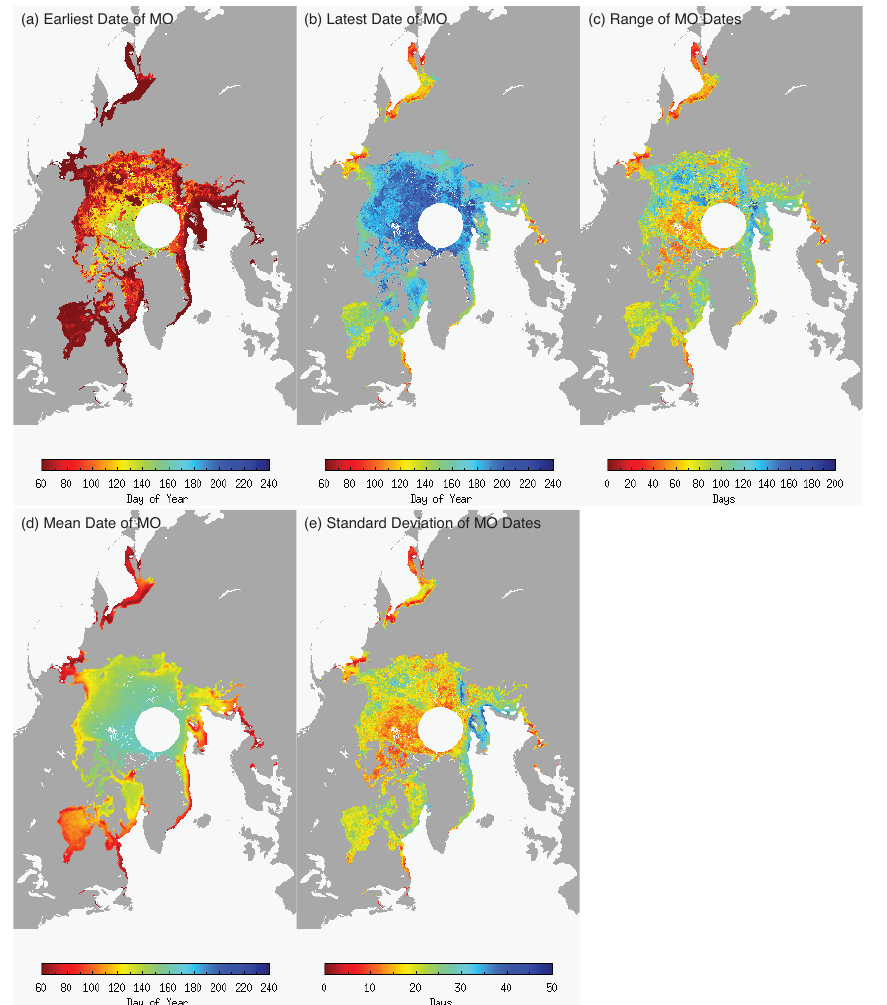
Figure 7. (a) Earliest, (b) latest, (c) range, (d) mean, and (e) standard deviation of melt onset dates for the 1979–2012 record (maps available from Anderson et al.,